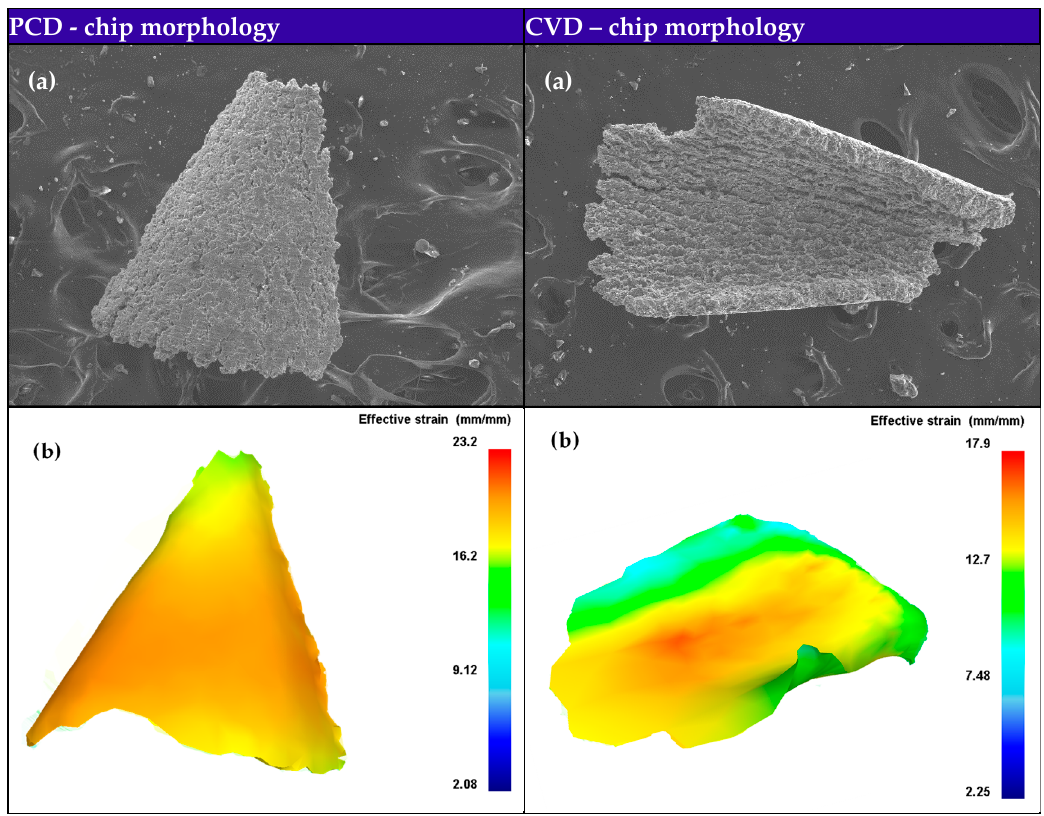
Figure 12. ( a ) Experimental and ( b ) simulated morphologies of the chips formed using PCD and CVD drills.